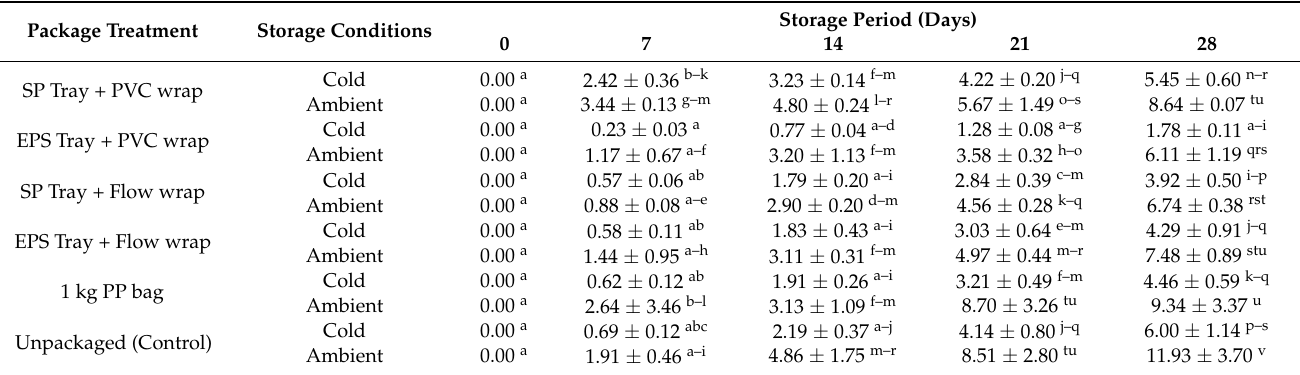
Table 1. The effects of the packaging and storage conditions on the physiological weight loss (%) of tomatoes over a 28-day storage period ( n =